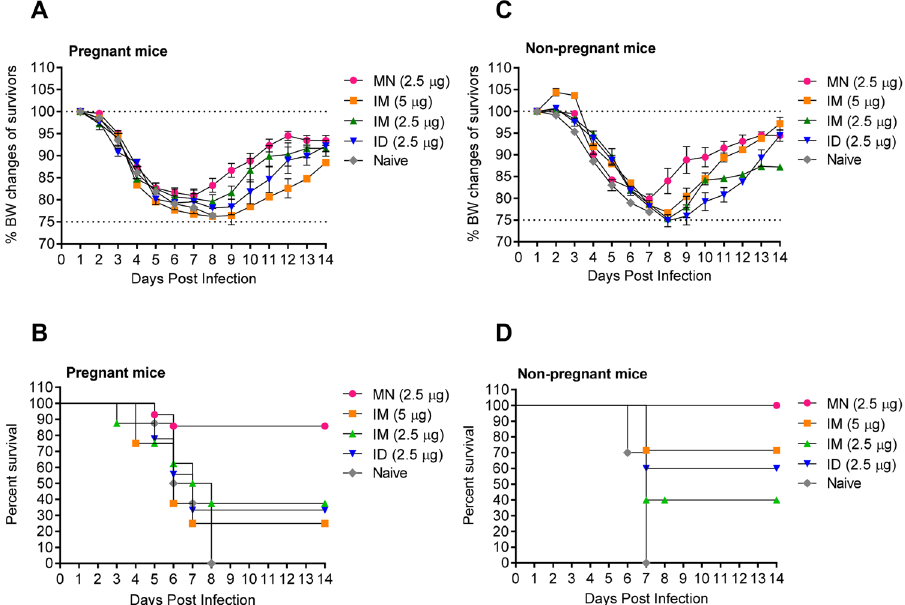
Figure 3. Protective immunity after lethal challenge with homologous virus of mice immunized during pregnancy. Immunized groups were challenged with mouse adapted A/Brisbane/59/07 (H1N1) virus 4 weeks after immunization. ( A and C ) Body weight changes and ( B and D ) survival rates after challenge with 5xLD 50 of virus were monitored for 14 days. Values are expressed as mean + / − SEM. (n = 5–14). Groups and animal numbers are as described in Fig. 2; * p < 0.05; ** p <